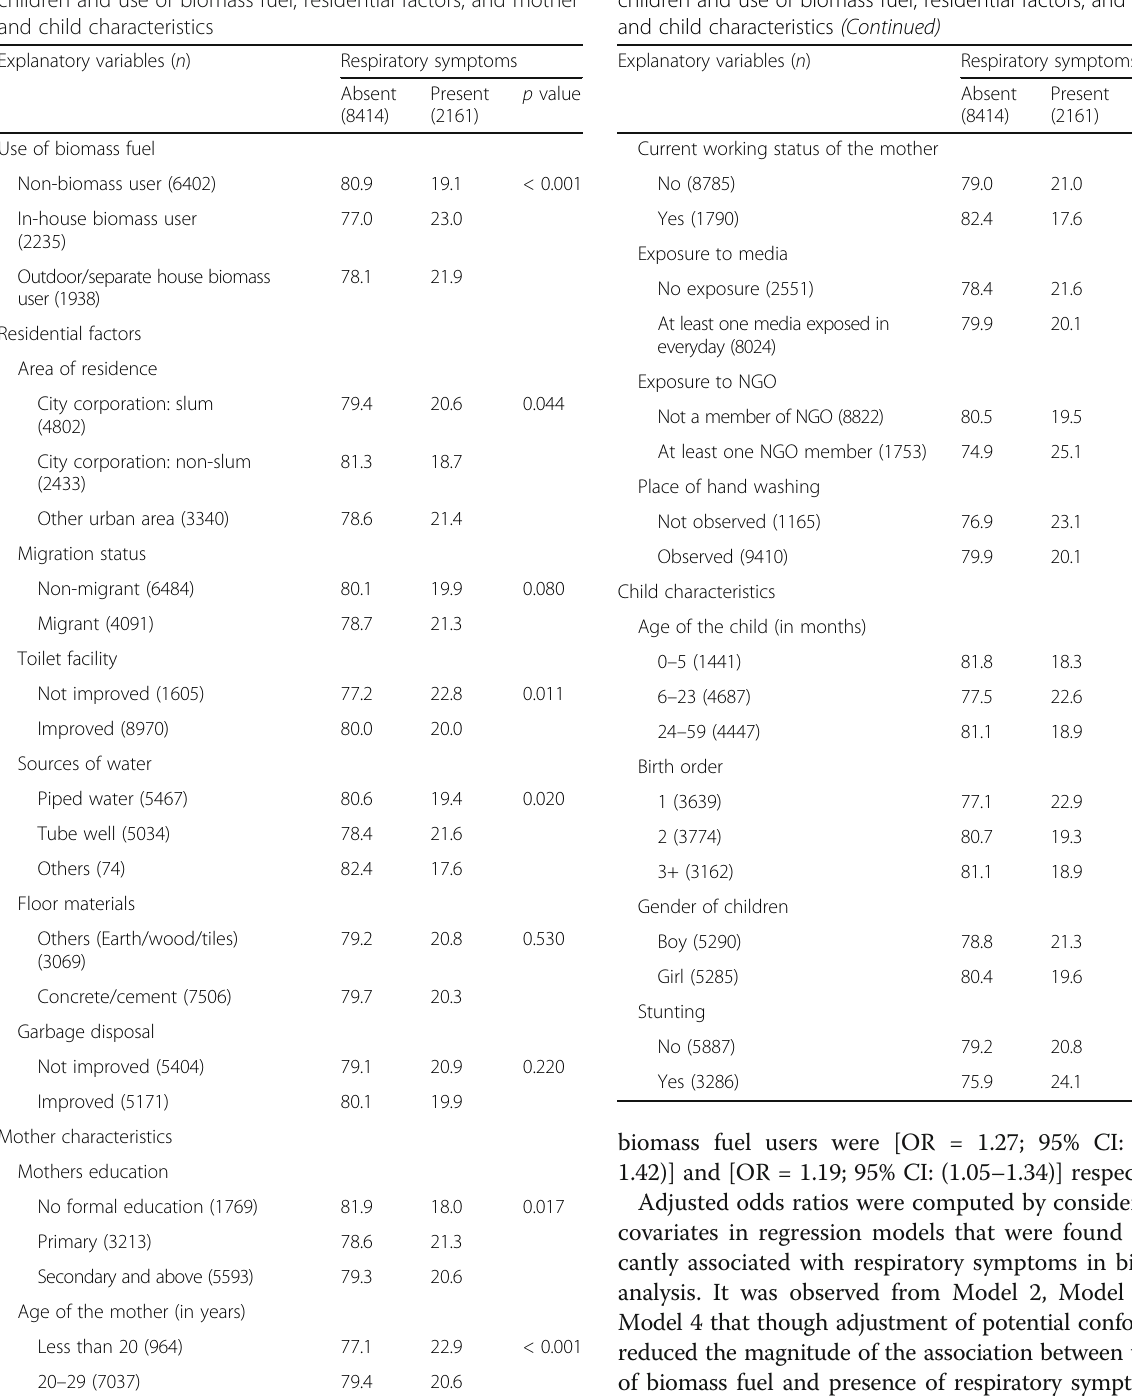
Table 2 Association between respiratory symptoms of the children and use of biomass fuel, residential factors, and